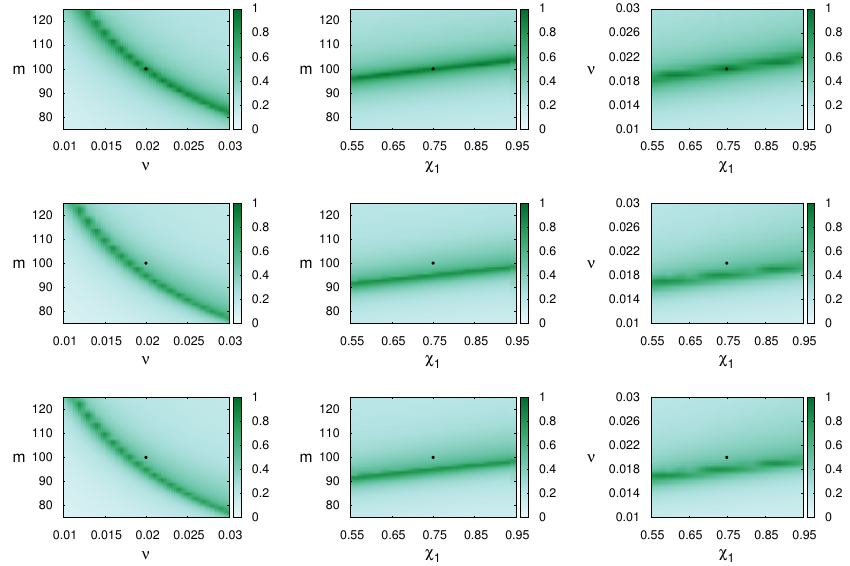
Figure 2. Match values M for two waveforms in the restricted parameter spaces [ m , ν ] , [ m , χ ] and [ ν , χ ] from left to right (the three rows representing SpinTaylorT4-SpinDominatedWf, 1 1 SpinDominatedWf-SEOBNRv3, SpinTaylorT4-SEOBNRv3 matches). The parameters of the first waveform (the template) are varied, while those of the second waveform (the signal, represented by a dot) are fixed as m = 100 M (cid:12) , ν = 0.02 and χ 1 = 0.75. The other parameters were chosen as f low = 10 Hz, ι = 0.5 The spins are